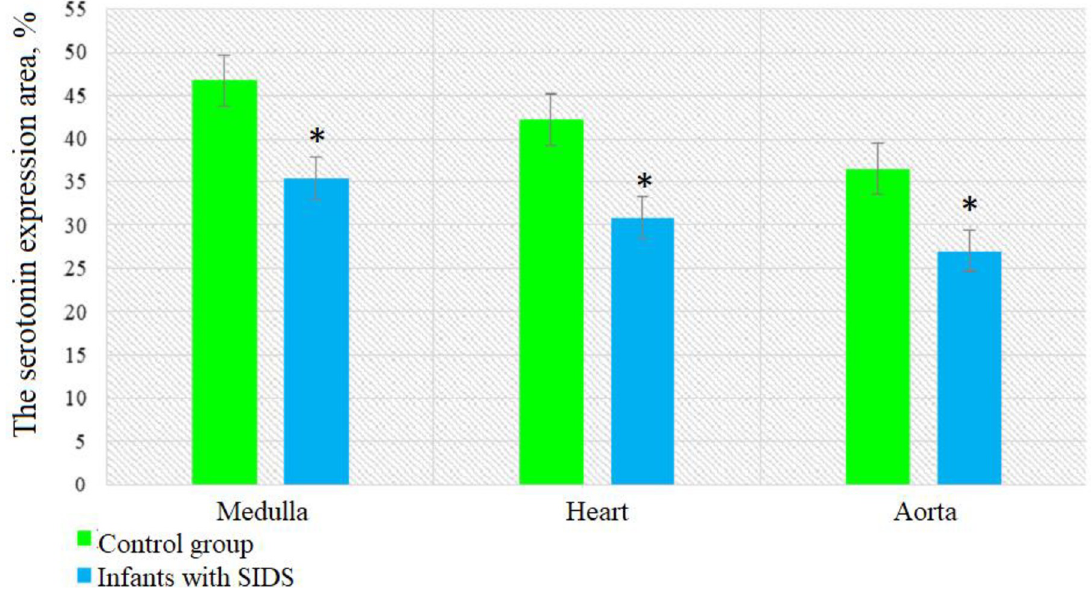
Fig 4. The serotonin expression area (mean ± SD) in medulla, heart, and aorta tissues of infants in the control group and infants with SIDS. � p < 0.05 –as compared with the respective index in the control